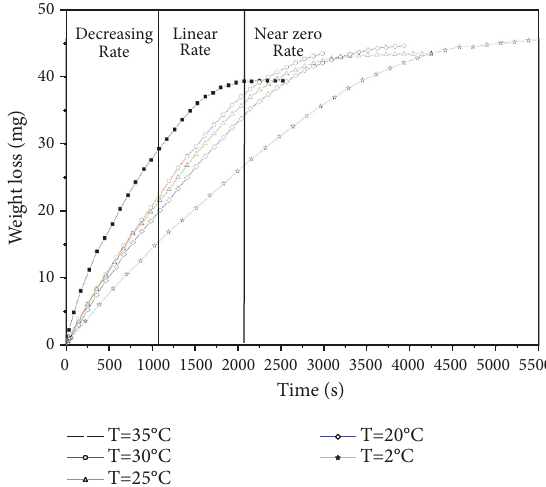
Figure 1: The water evaporation progress at different film formation temperatures.